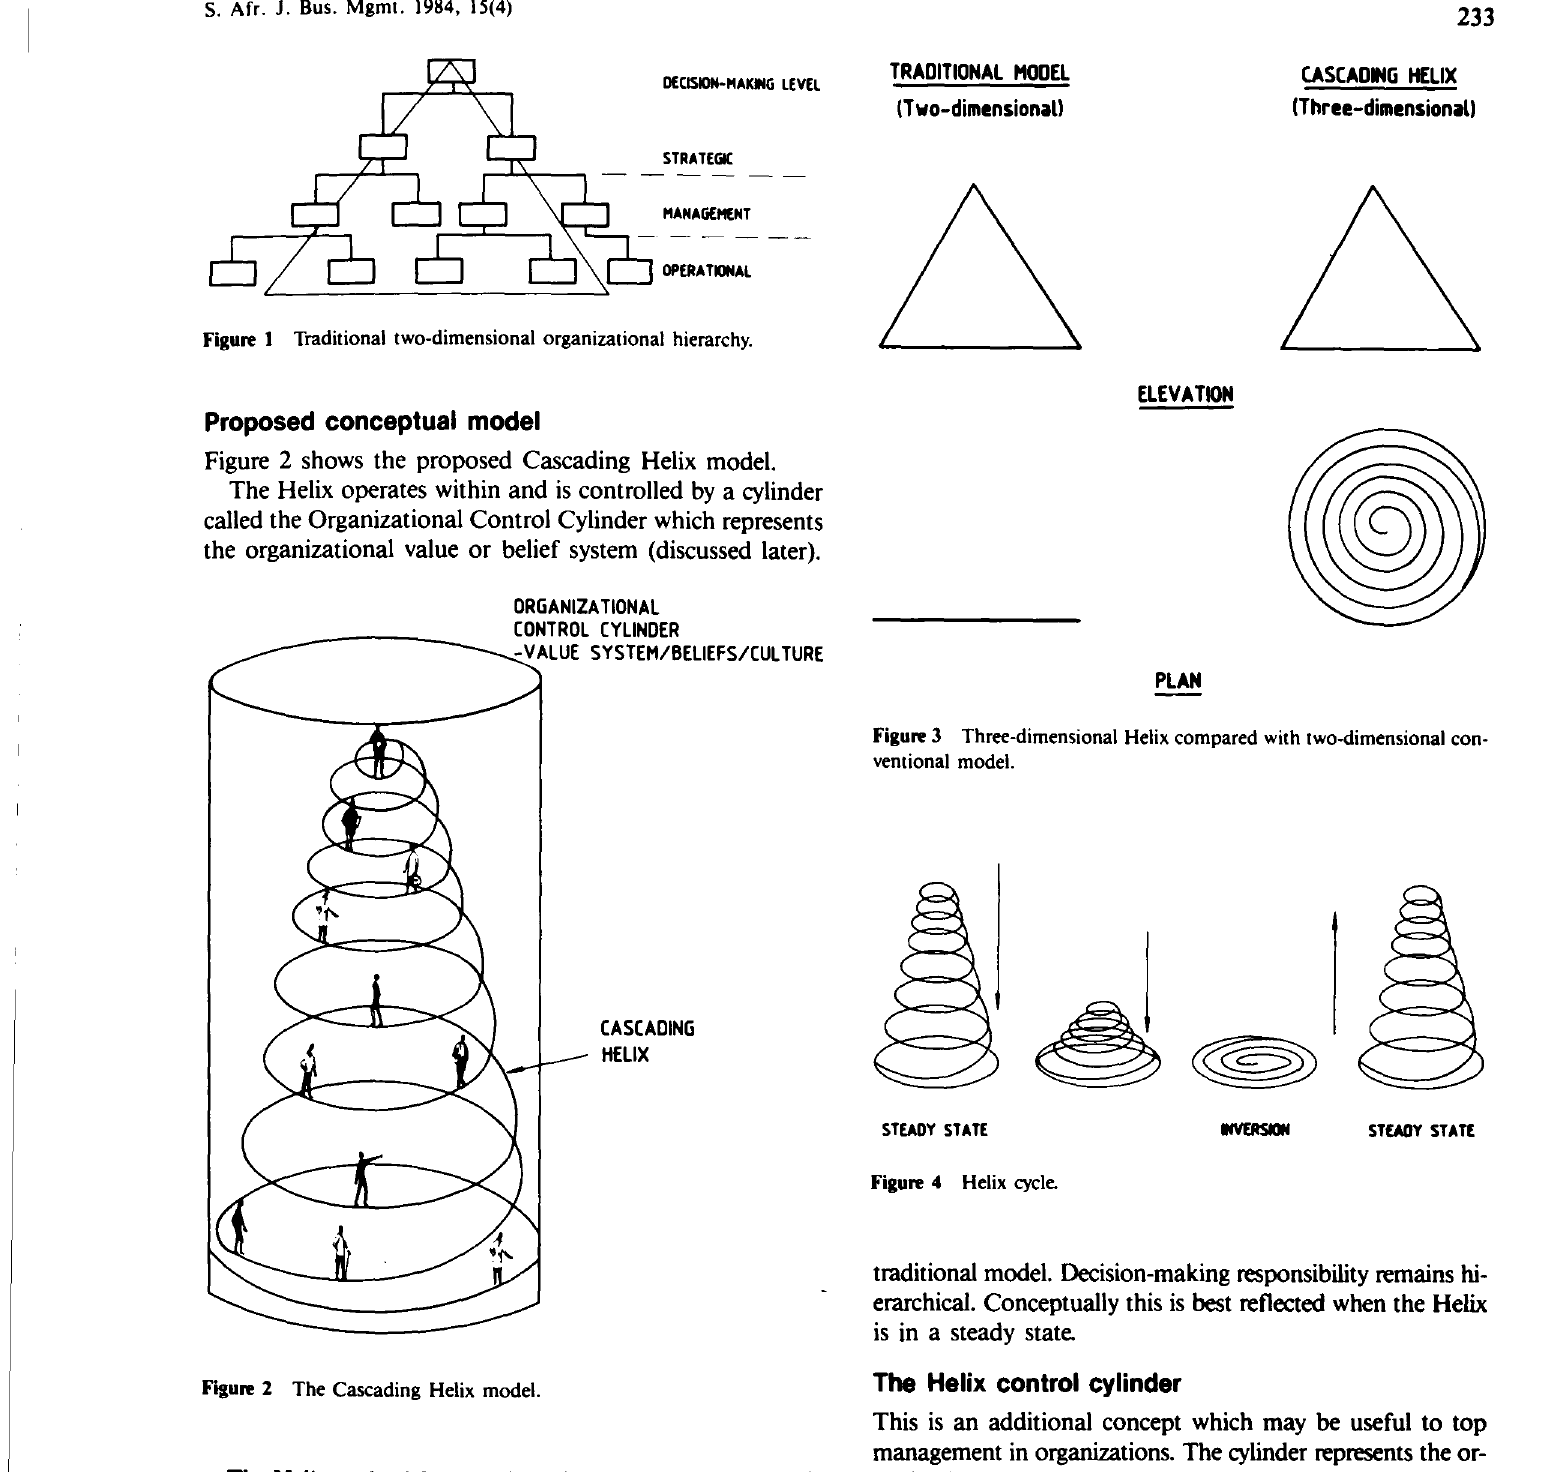
Figure 2 The Cascading Helix model.